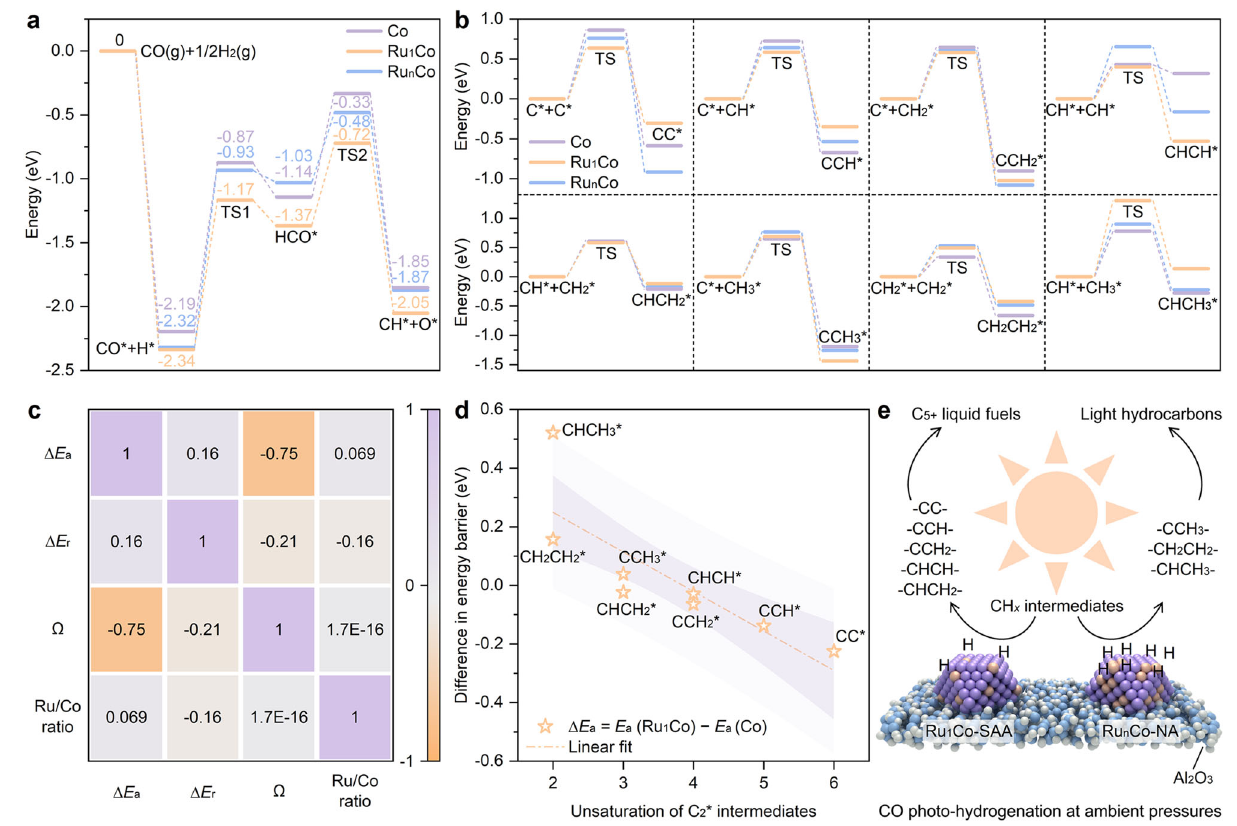
Fig. 6 | Reaction paths and energy barriers based on DFT calculations. a Potentialenergypro fi leofCO*dissociation. b Potentialenergypro fi leofeightC-C coupling paths for C 2 * intermediates. c Correlation analysis between the unsa- turation of C 2 * intermediates relative to ethane ( Ω ) and the energy barrier reduc- tion( Δ E a )ofRu 1 Co-SAAminusCo-NP. d Linearcorrelationbetweenunsaturationof